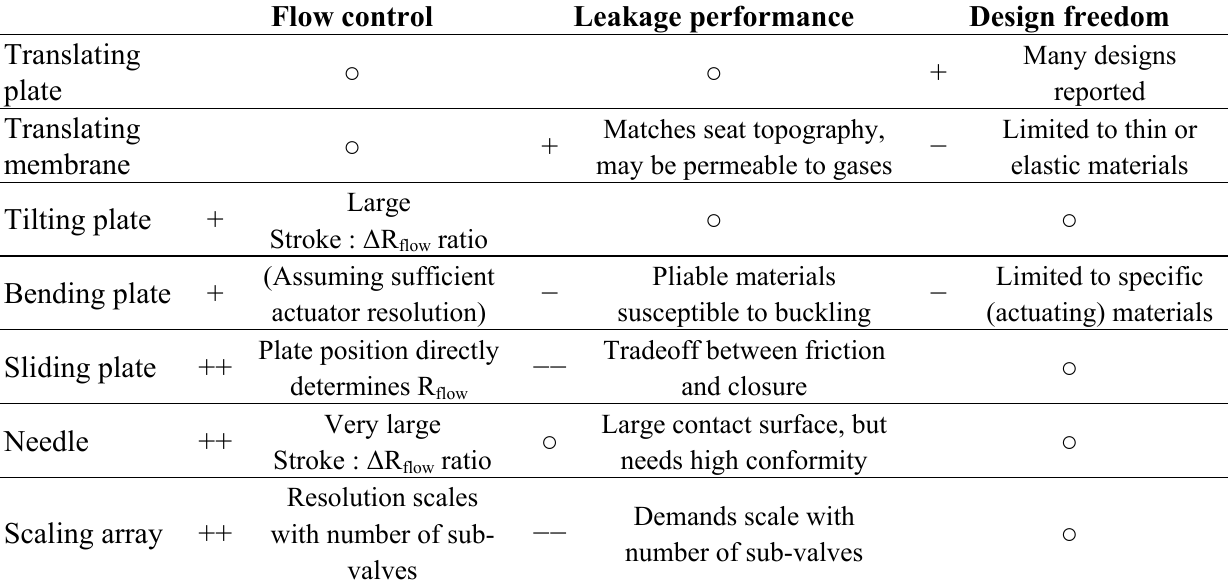
Table 3. Summary of the valve concepts described in Section